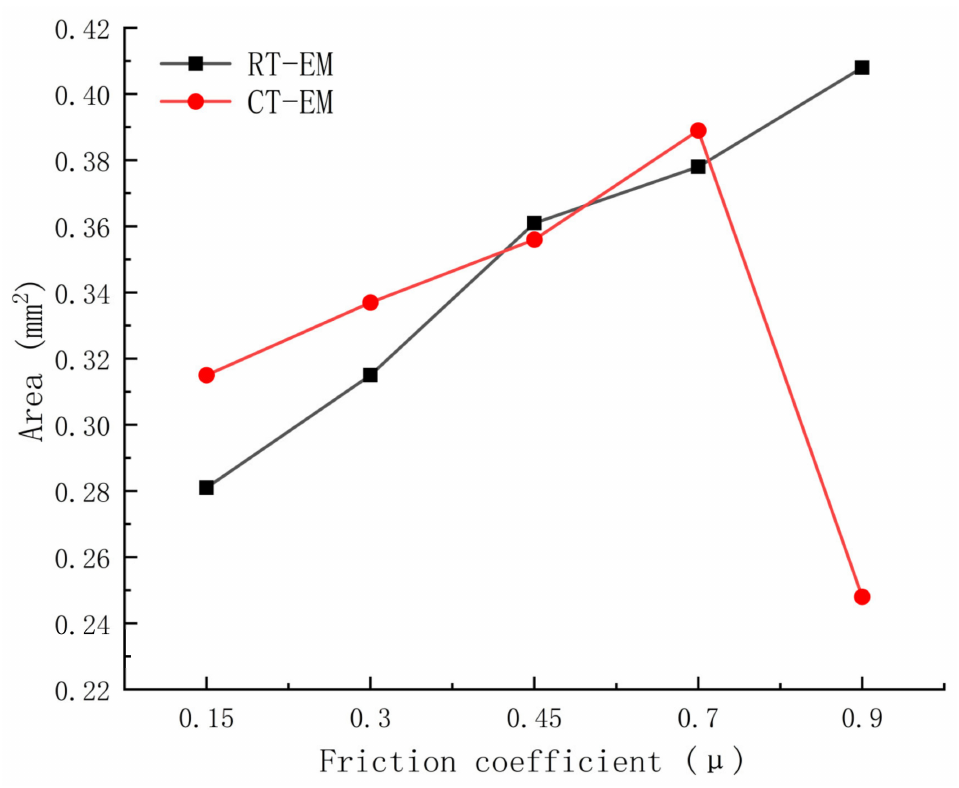
Figure 21. Cross-sectional area of the micro-groove